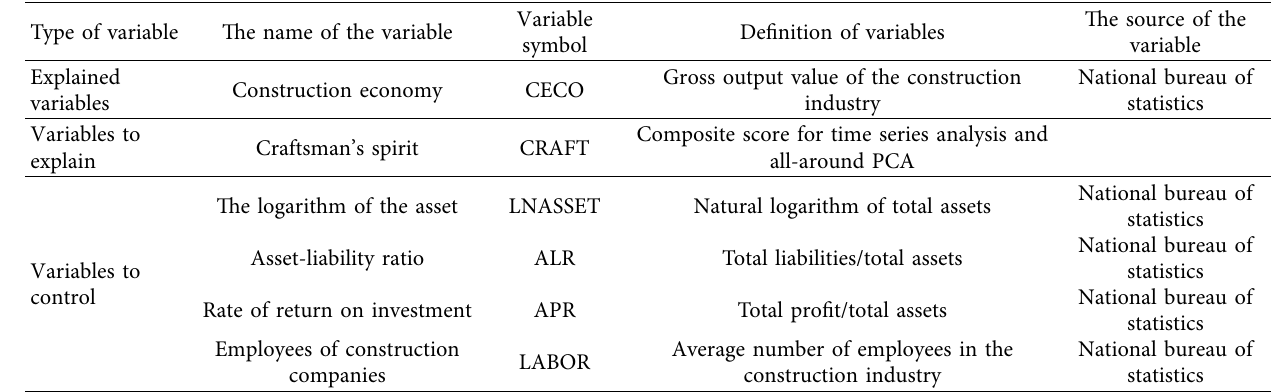
Table 2: Variable definition